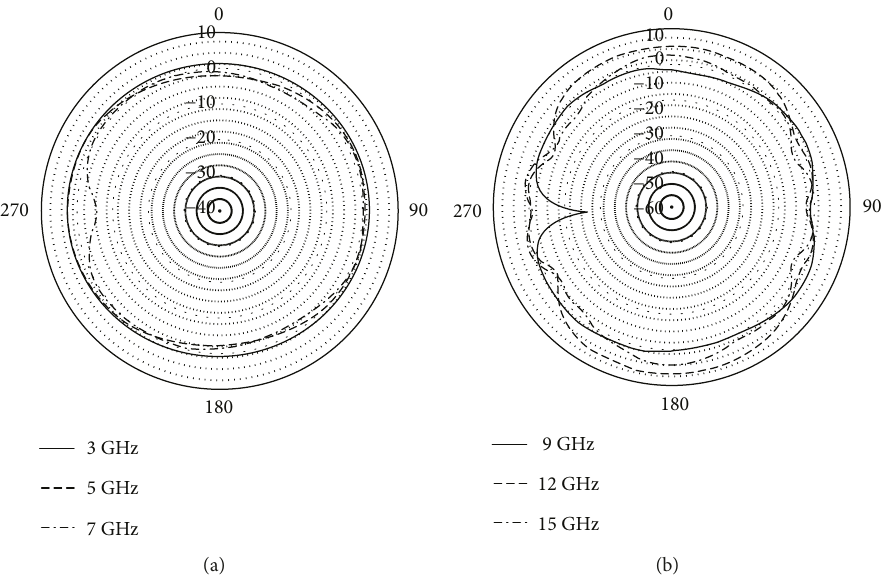
Figure 7: Simulated radiation gain patterns in the XY plane: (a) 3, 5, and 7GHz and (b) 9, 12, and 15 GHz.